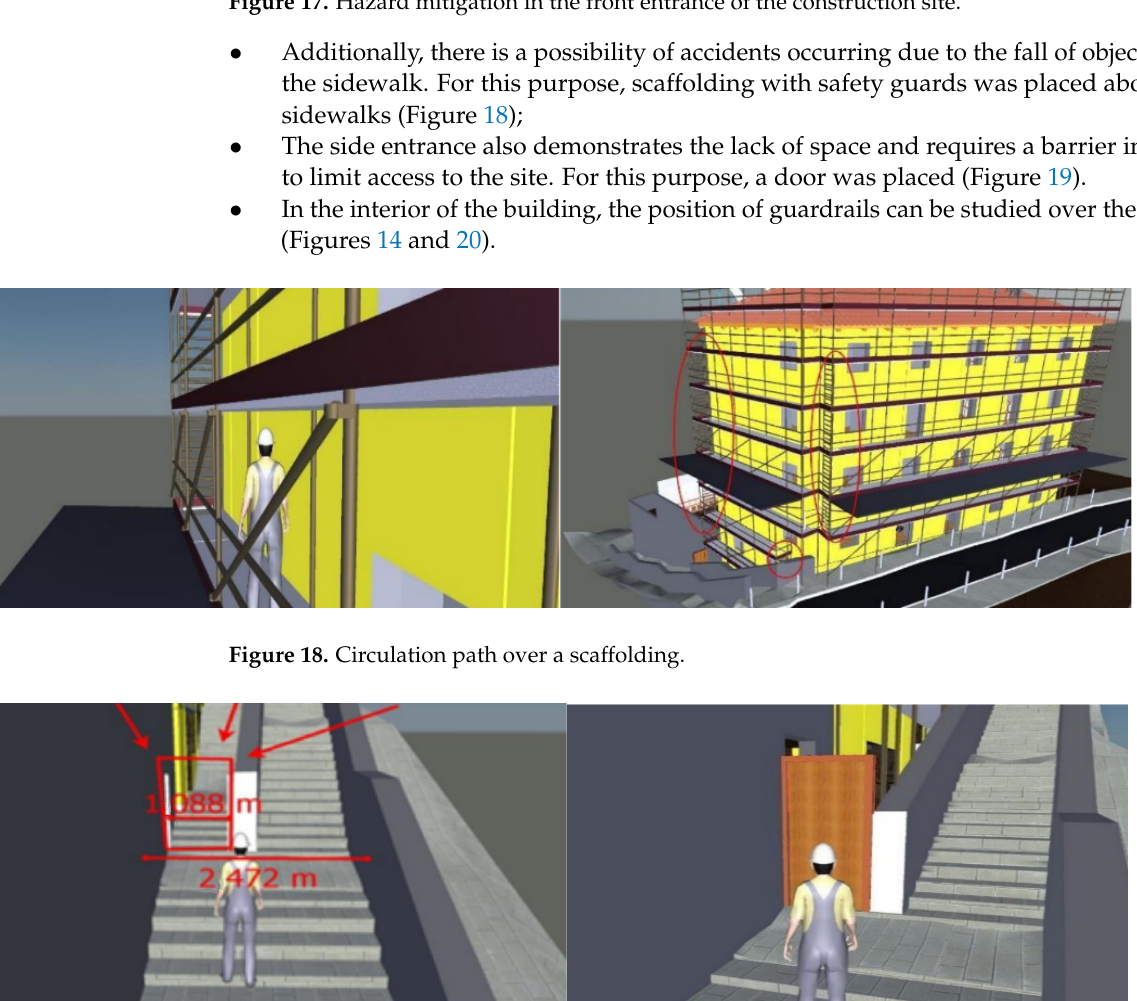
Figure 20. Study of a guardrail location. The study of the movement of the steel elements raised to each level can be analyzed over the model, supported by the walkthrough allowed by an avatar and the modeling of a suspended platform (Figure 21). This also enables the impact of the positioning of the platform and limitations of access due to the location of the openings in the façade or installed equipment (Figure 22).